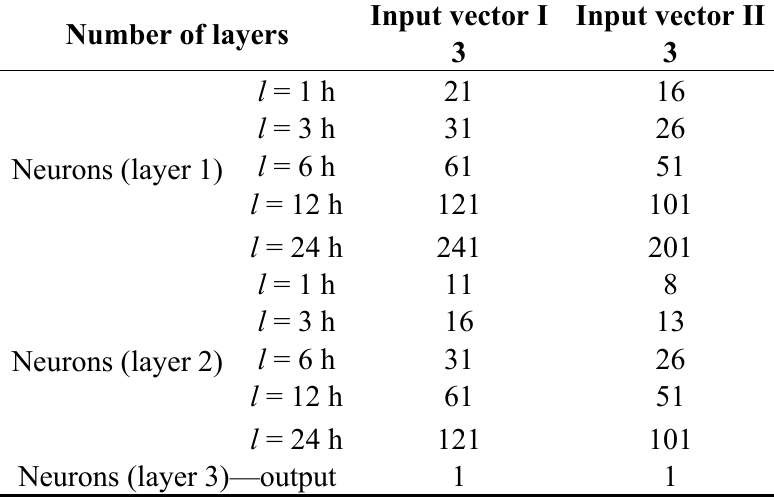
Table 3. Elman network parameters used in the training